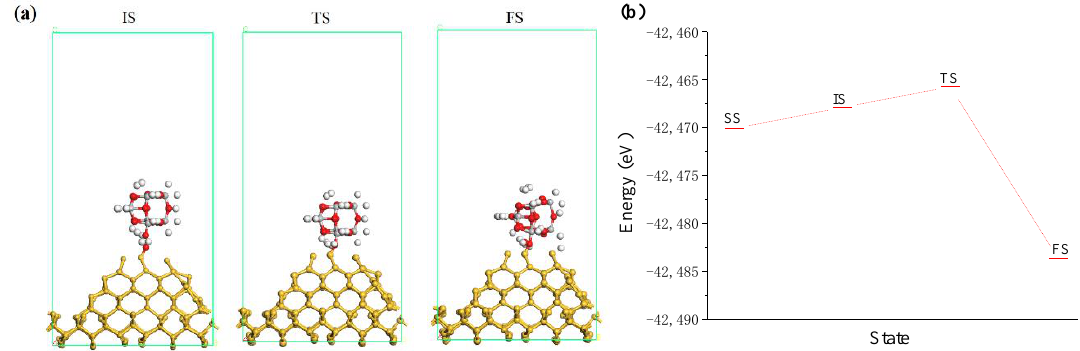
Figure 8. The interaction between incident TiO 2 cluster and silicon surface. ( a ) Interaction states where white, red, grey and yellow balls are hydrogen, oxygen, titanium and silicon atoms, respectively; ( b ) system energy of interaction states.